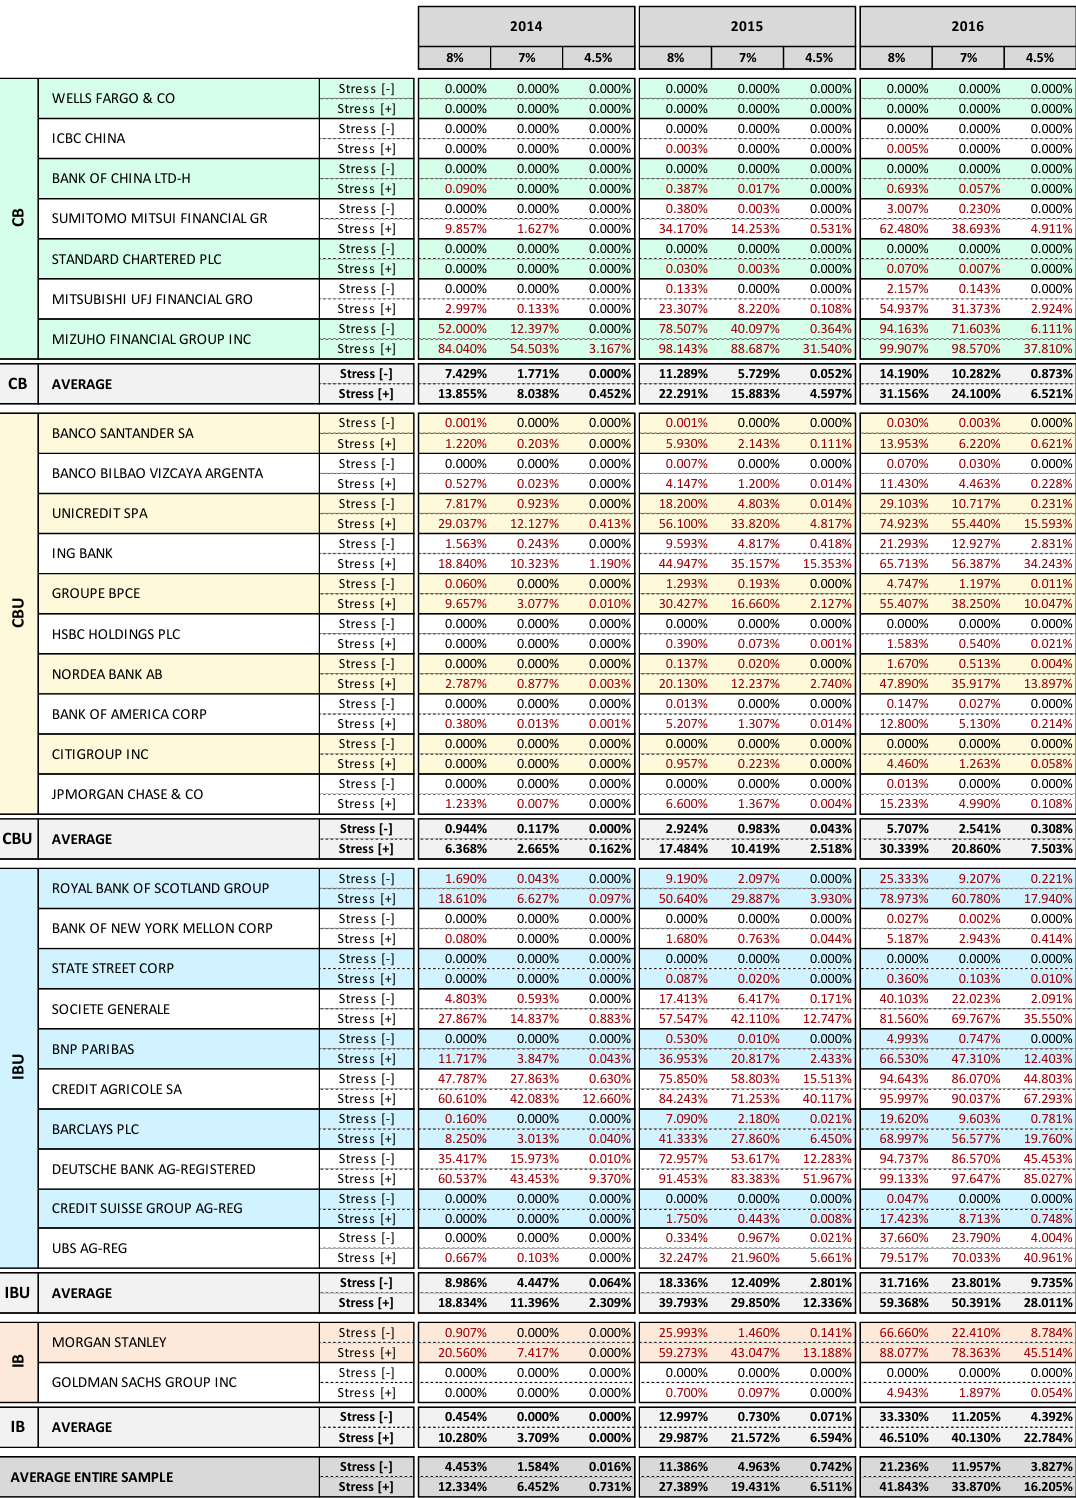
Figure 6. CET1 ratio probability of breach.